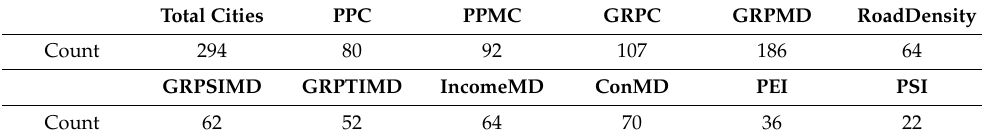
Table 5. Number of cities in which individual indicators contributed to